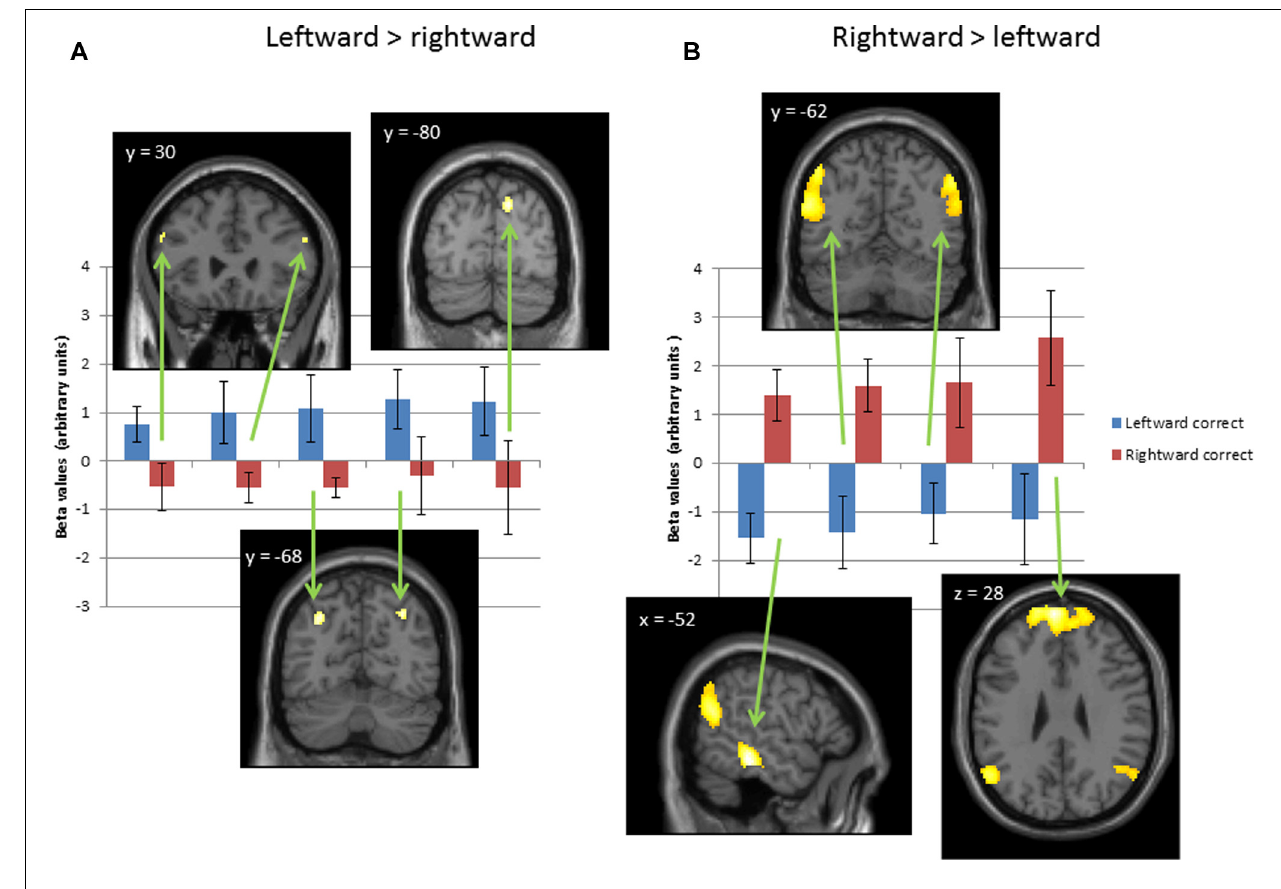
translation greater than leftward translation.Threshold p < 0.05 uncorrected, 10 contiguous voxels.The graphs show mean and standard error beta values in regions indicated by the arrows for correctly identified leftward (blue) and rightward (red) motion